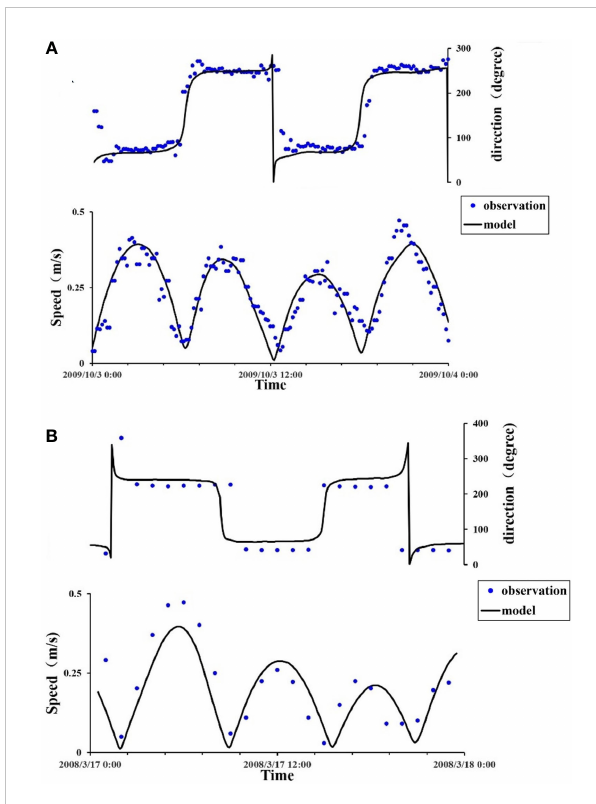
FIGURE 4 Current speed comparison between model results and measured data at (A) Station P 2 , (B) Station P 5 .